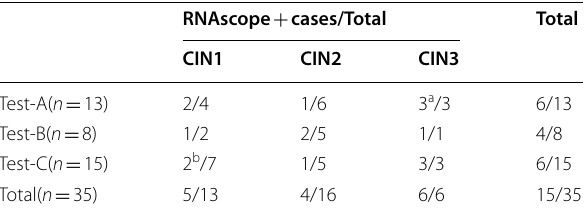
Table 4 The number of CIN1-CIN3 cases and RNAscope positive cases in the test